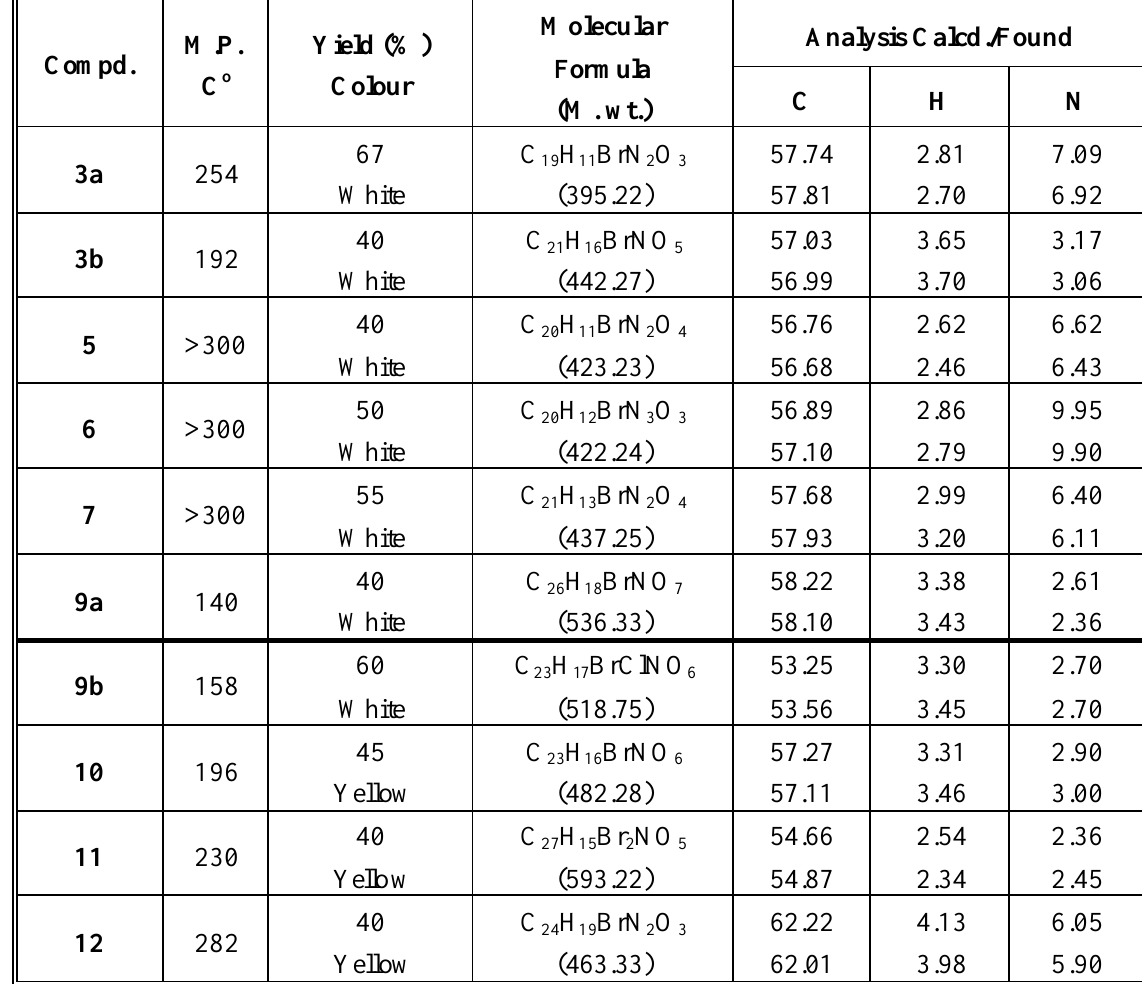
Table 3. Characterization data of the prepared compounds